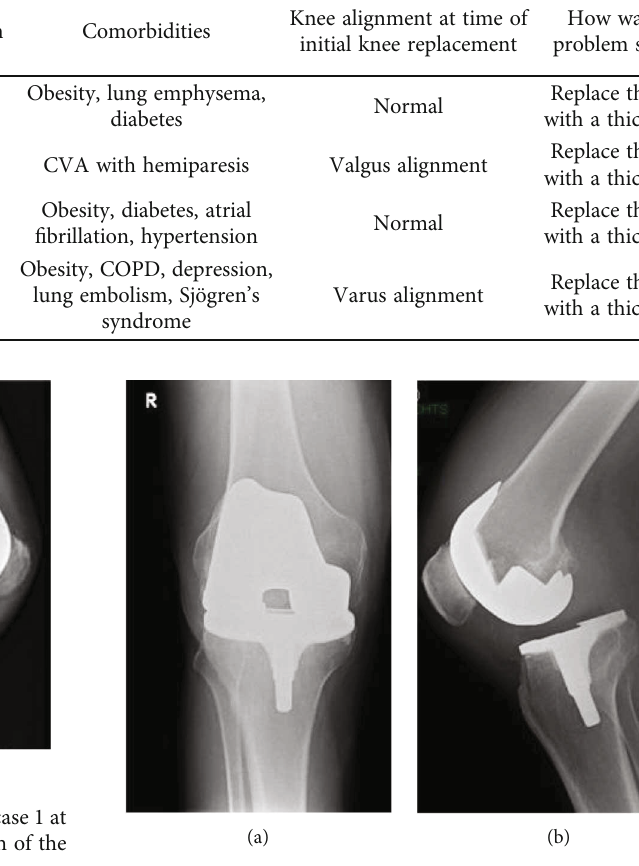
2: (a) Anteroposterior radiograph of case 2 at presentation in the emergency room. (b) Lateral radiograph of case 2 at presentation in the emergency